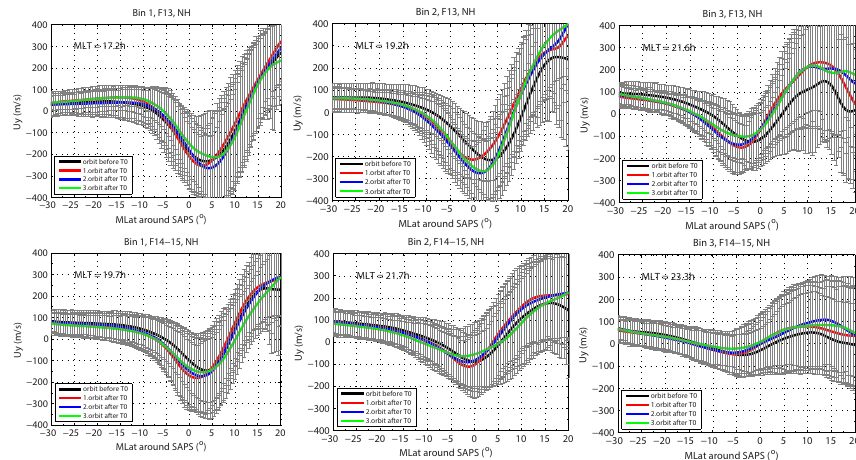
Figure 6. As Fig. 3, but for the zonal wind. Negative denotes westward (sunward)